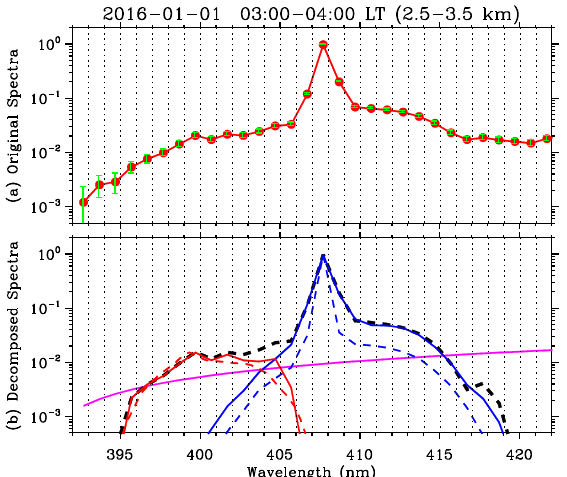
Fig. 4 Spectra measurement results for an ice virga event: (a) original normalized spectra with a second peak near 400 nm; (b) separated spectra components: fluorescence spectra (magenta), total mixed-phased water Raman spectra (dash black), vaporous (solid blue) and condensed (solid red) water Raman spectra. Theoretical water vapor (dash blue) and ice (dash red) water Raman spectra are added for comparison. The theoretical ice Raman spectra are taken from